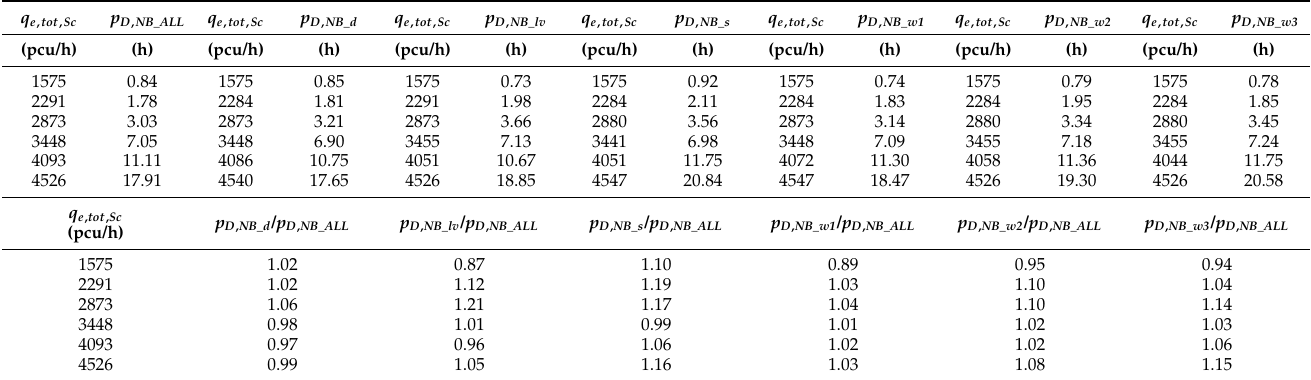
Table 3. Total delays in simulated network depending on q e , tot , Sc for simulation scenarios NB_ALL and NB_c , along with index